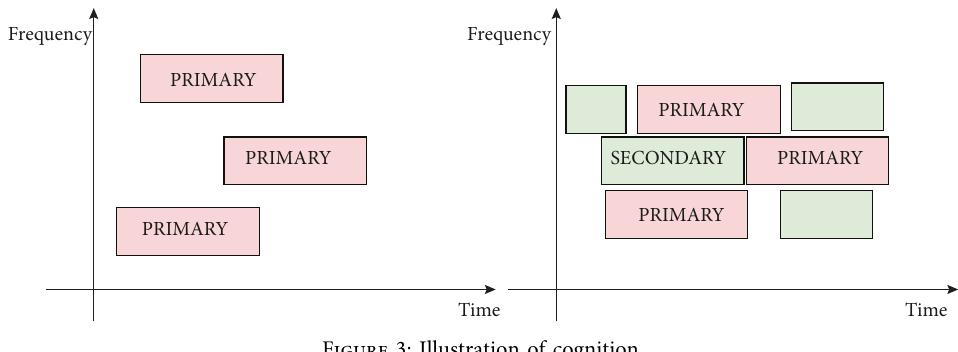
Figure 3: Illustration of cognition.